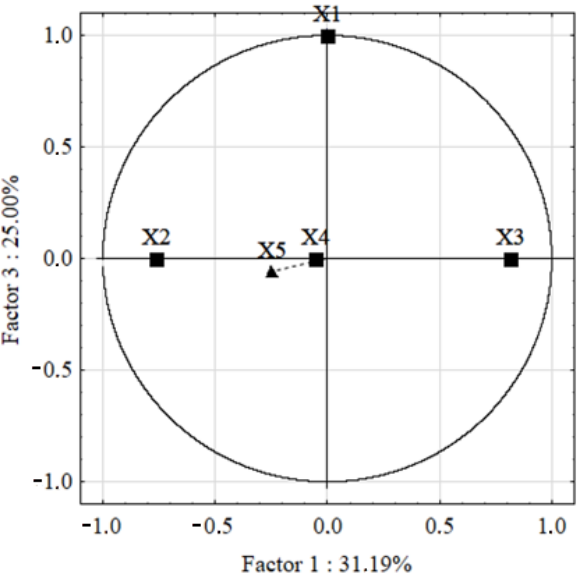
Figure 7. Biplot graph with projections of the loadings of the main components PC1 and PC3.